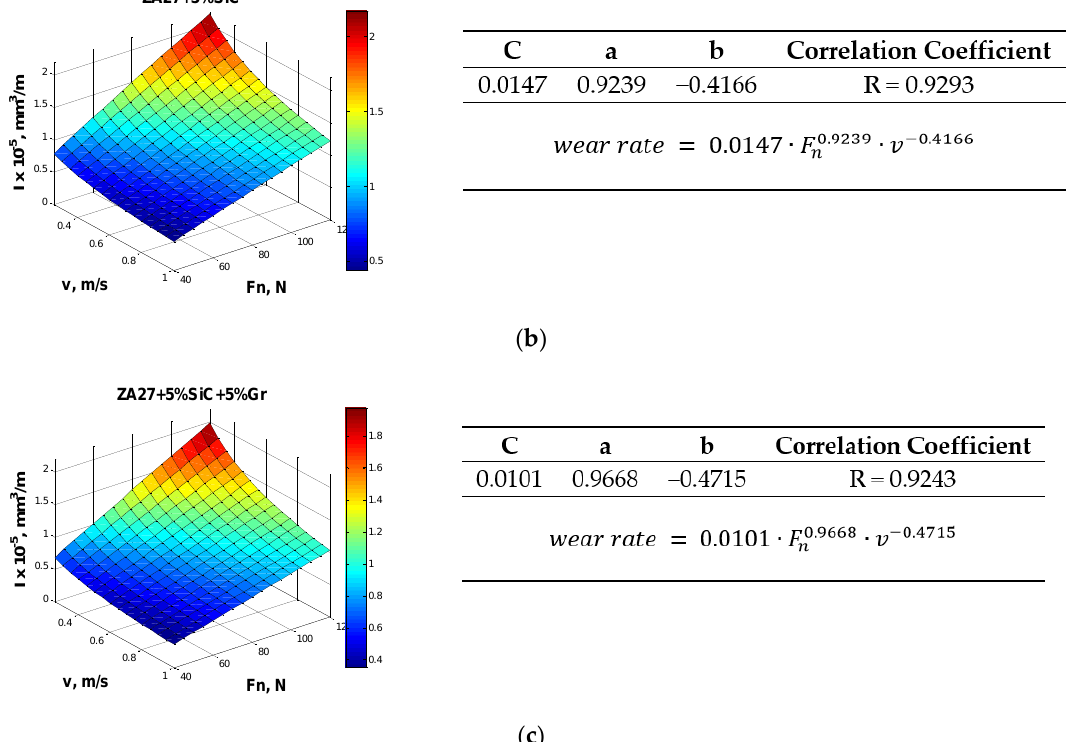
Figure 6. The wear-rate regression surface diagrams and parameters for: ( a ) ZA27; ( b ) ZA27/5%SiC ( c ) ZA27/5%SiC/5%Gr.